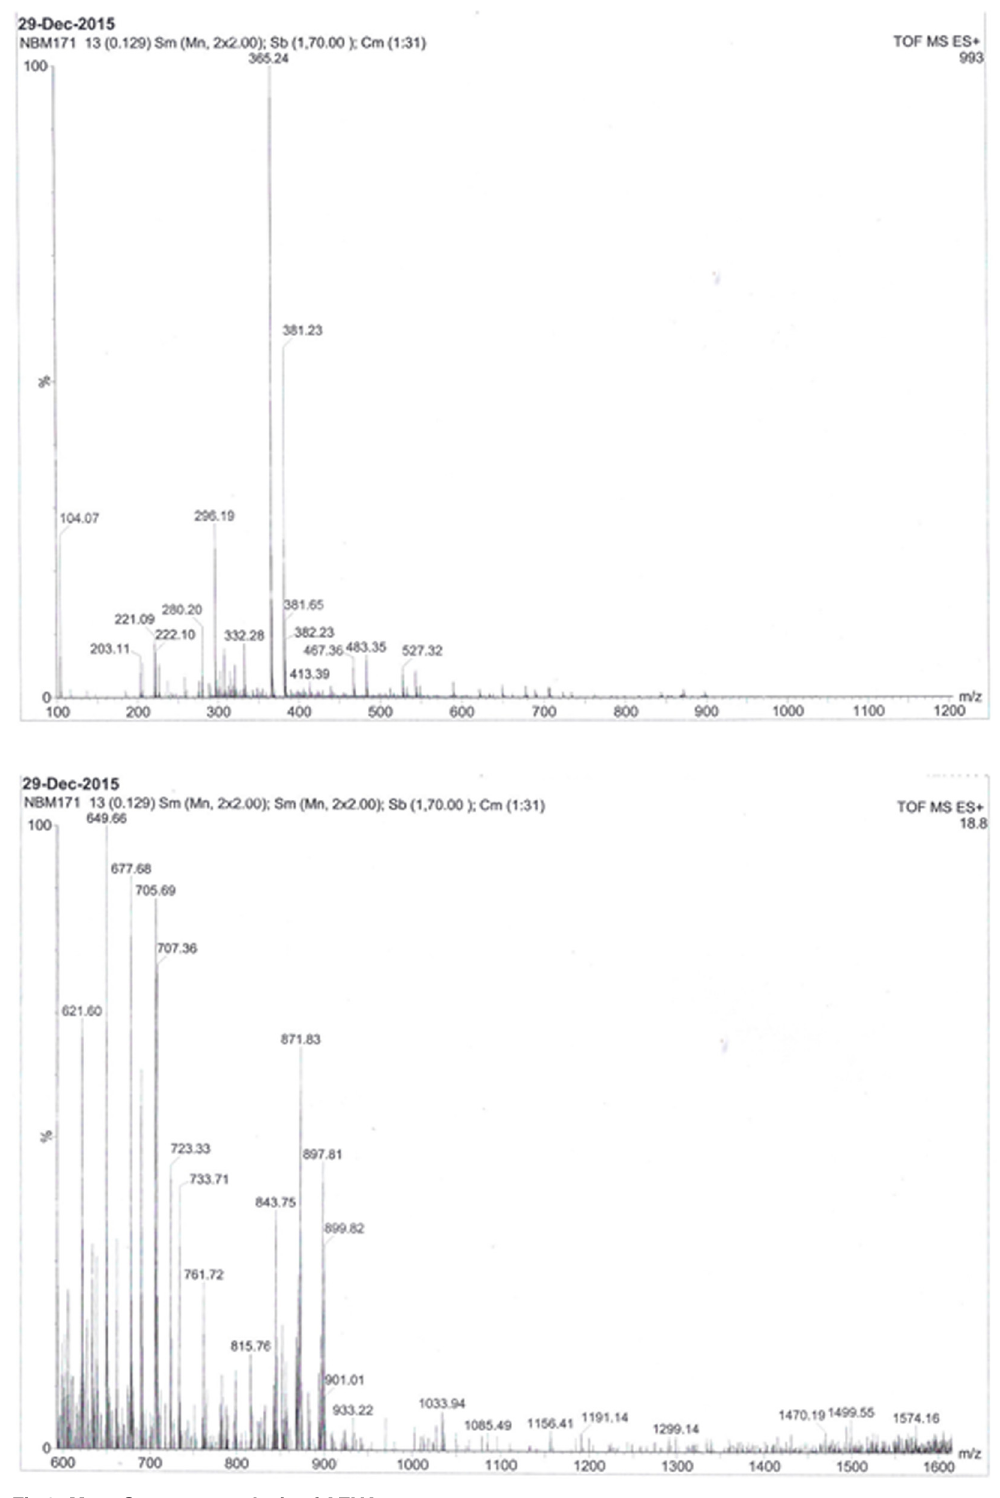
Fig 2. Mass Spectrum analysis of AEVA.